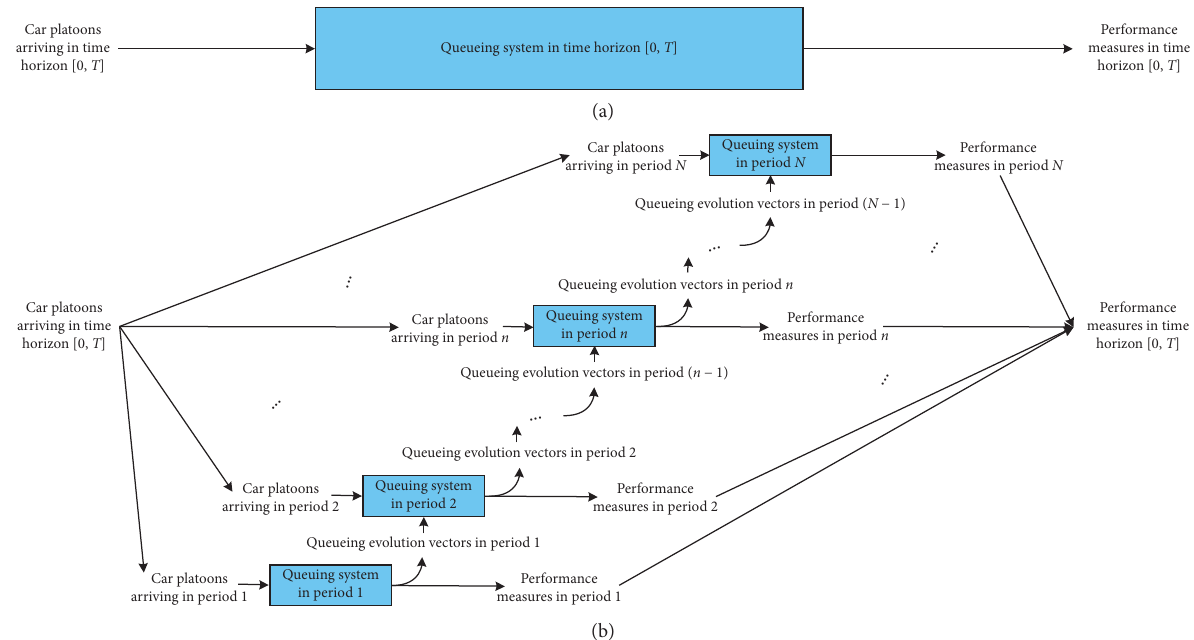
Figure 2: Simulation for the entire time horizon and subsimulations based on periods. (a) Simulation for the entire time horizon. (b) Simulations on a period-by-period